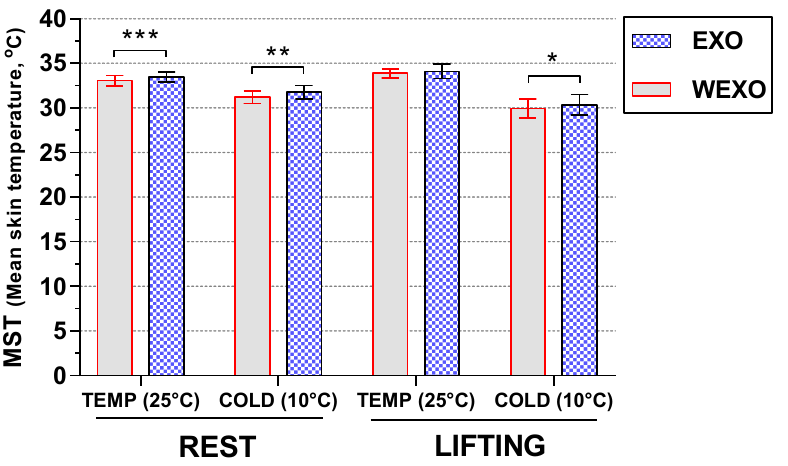
Figure 6. MST in steady − state condition.3.3. Results of TSV (* p < 0.05, ** p < 0.01, *** p < 0.001).